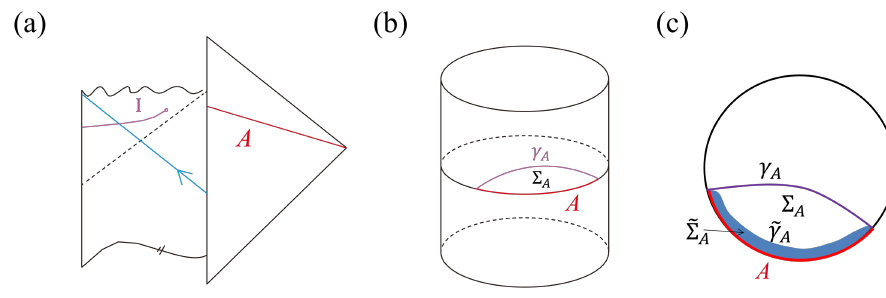
Figure 2 . (a) Entanglement island in an AdS black hole coupled with flat space bath. (b) A boundary region A of the AdS space, when there is no bath. (c) A top view of the spatial slice in (b), with the regularized region ˜Σ A and its boundary ˜ γ A (see